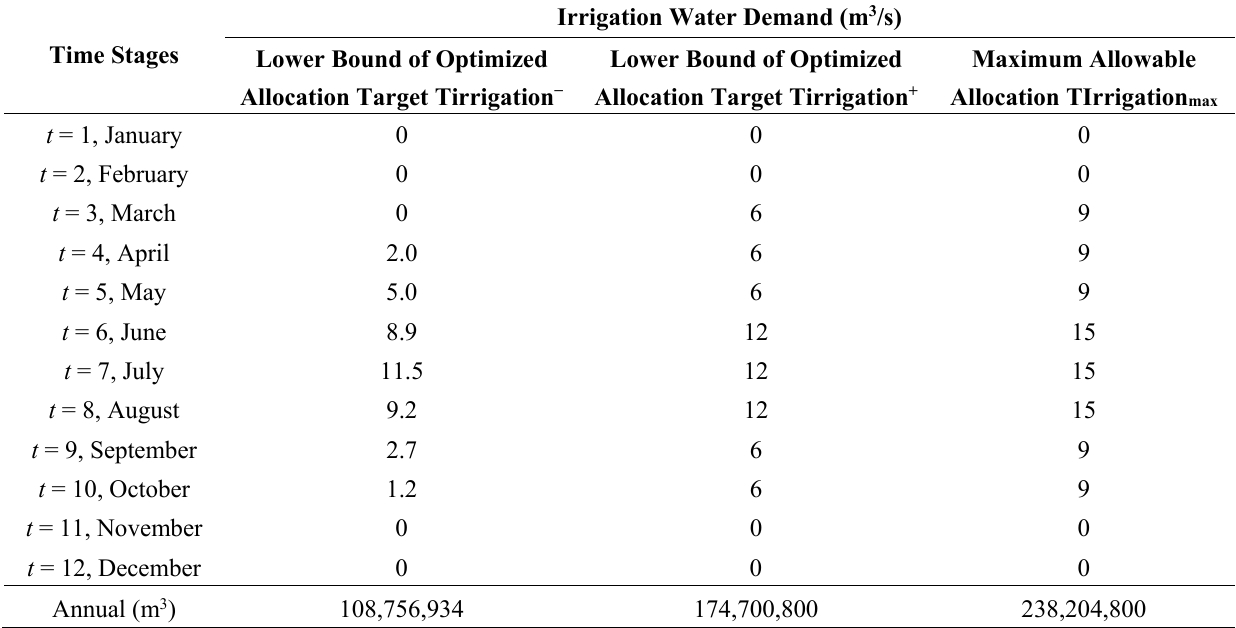
Table 10. Upper, lower and maximum allowable water allocation targets for irrigation in €/m 3